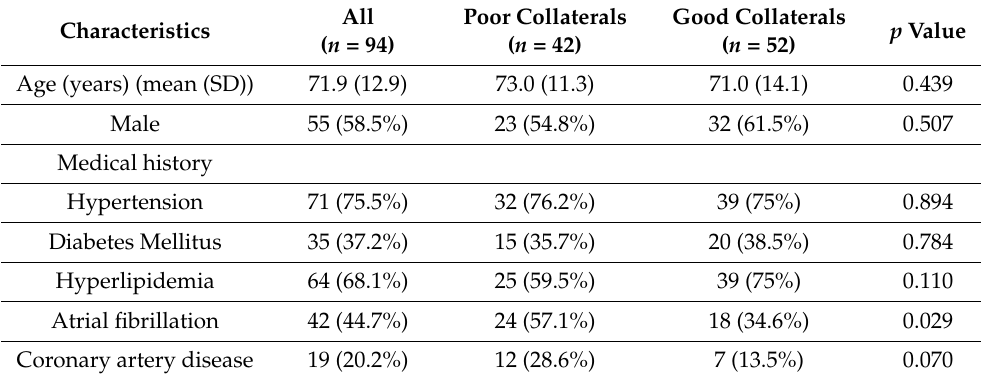
Table 1. Demographic characteristics of patients with poor collaterals (score 0–3) and good collaterals (score 4–5) based on multiphase CT angiography collateral score in acute ischemic